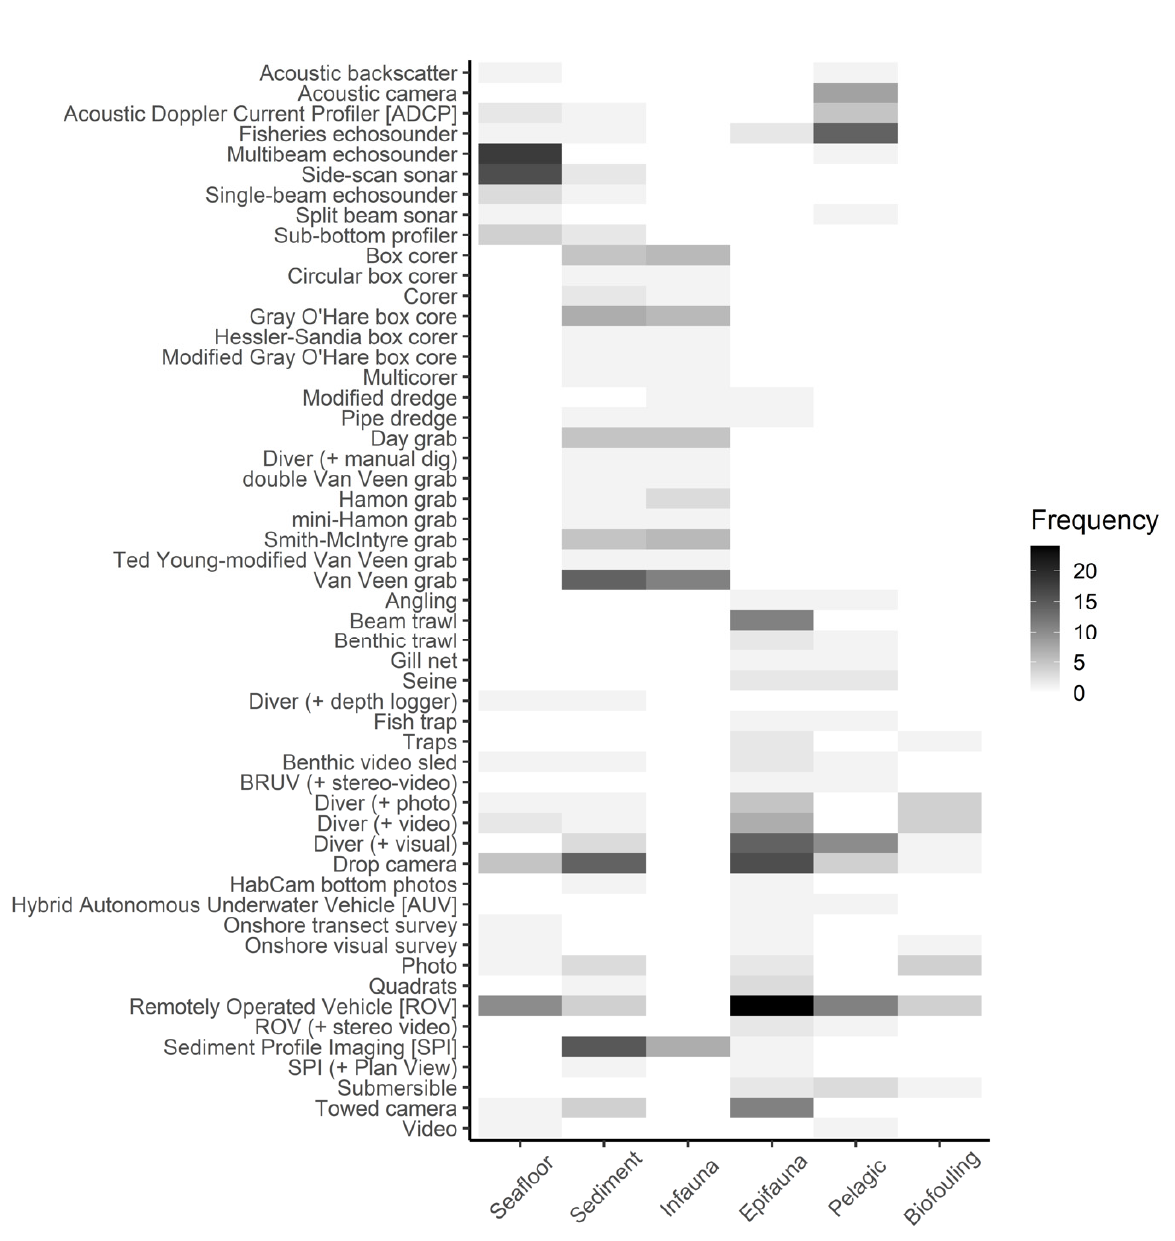
Figure 2. Heatmap showcasing the preponderance of sampling technologies across habitat categories; the darker the color, the more frequently used the technology. Only technologies that were used for two or more habitat categories are represented here.